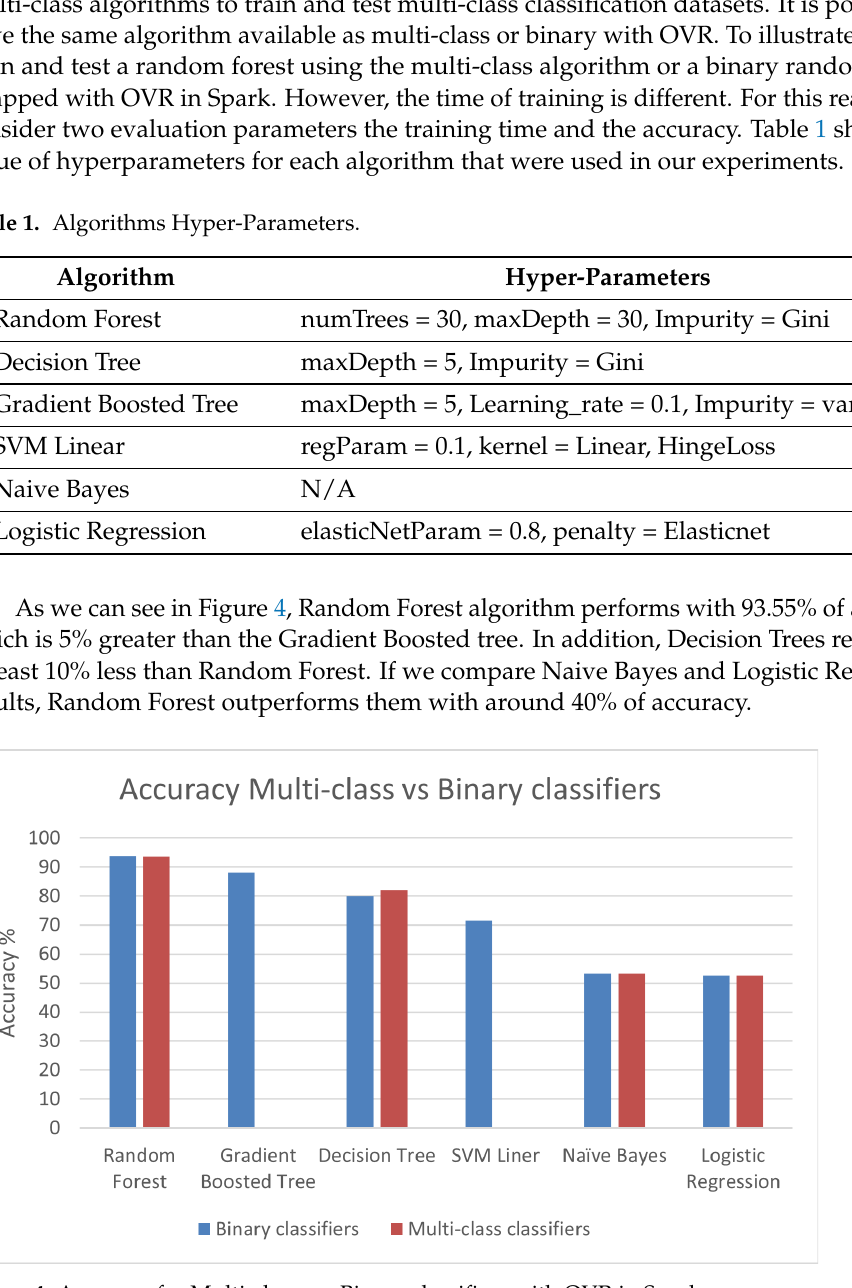
Figure 4. Accuracy for Multi-class vs. Binary classifiers with OVR in